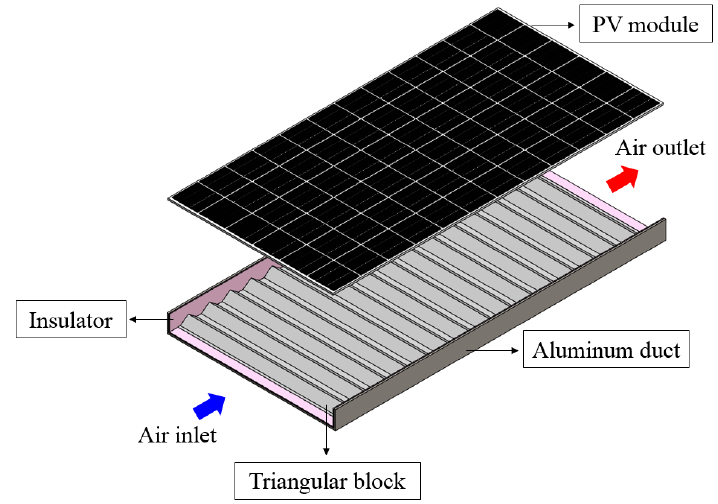
Figure 1. Composition of the PVT air collector coupled with a triangular block. (Reprinted/adapted with permission from Ref. [33]. Copyright 2020, Elsevier Ltd.).